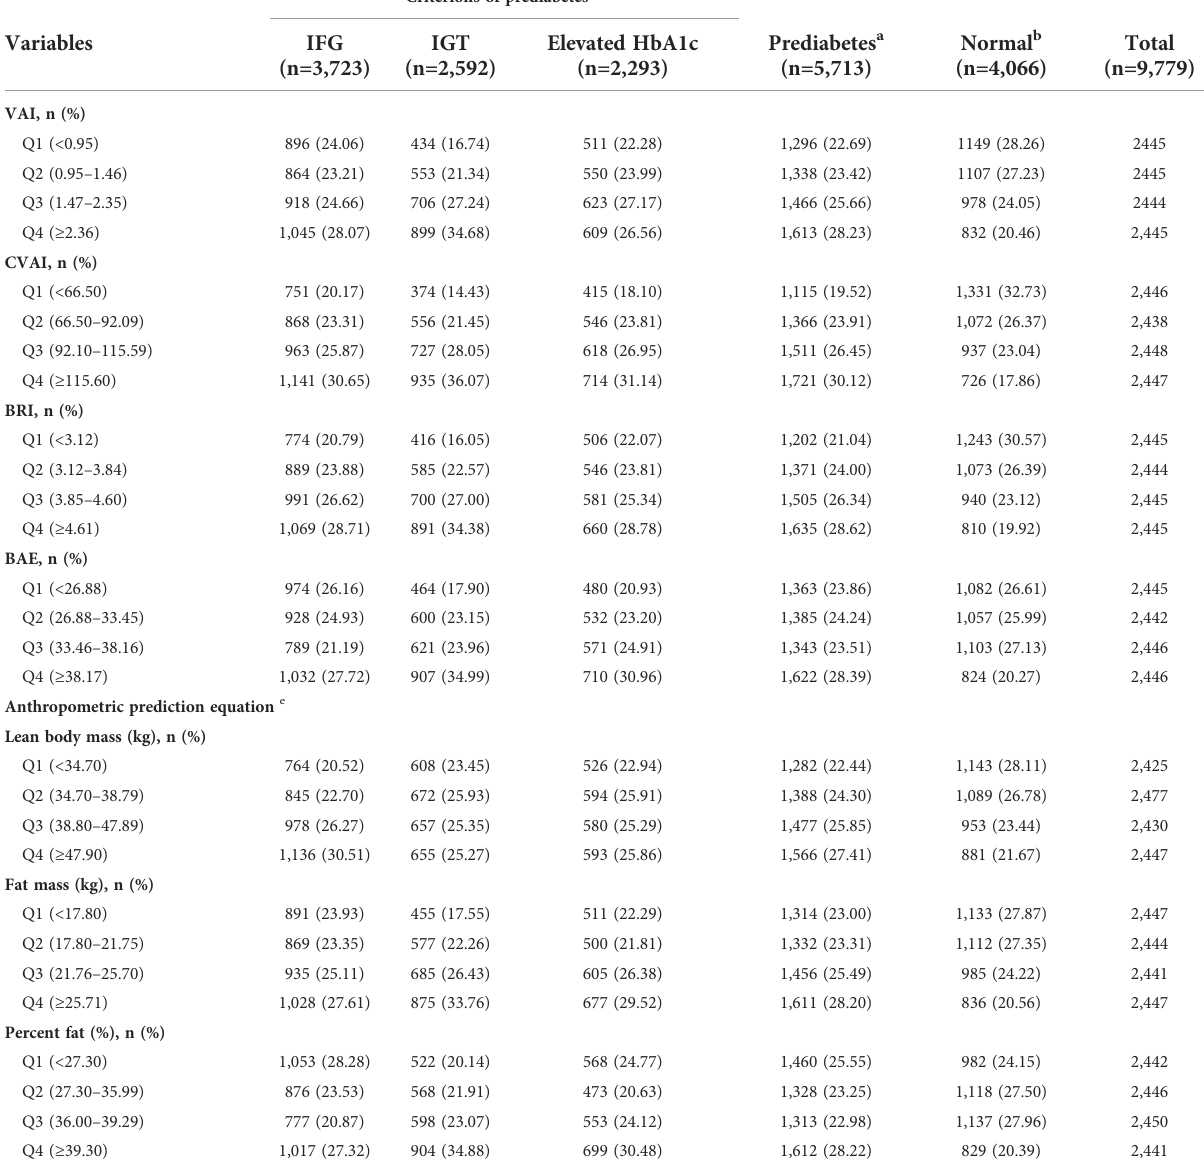
(Figure 6). For IFG, the odds of predicted lean body